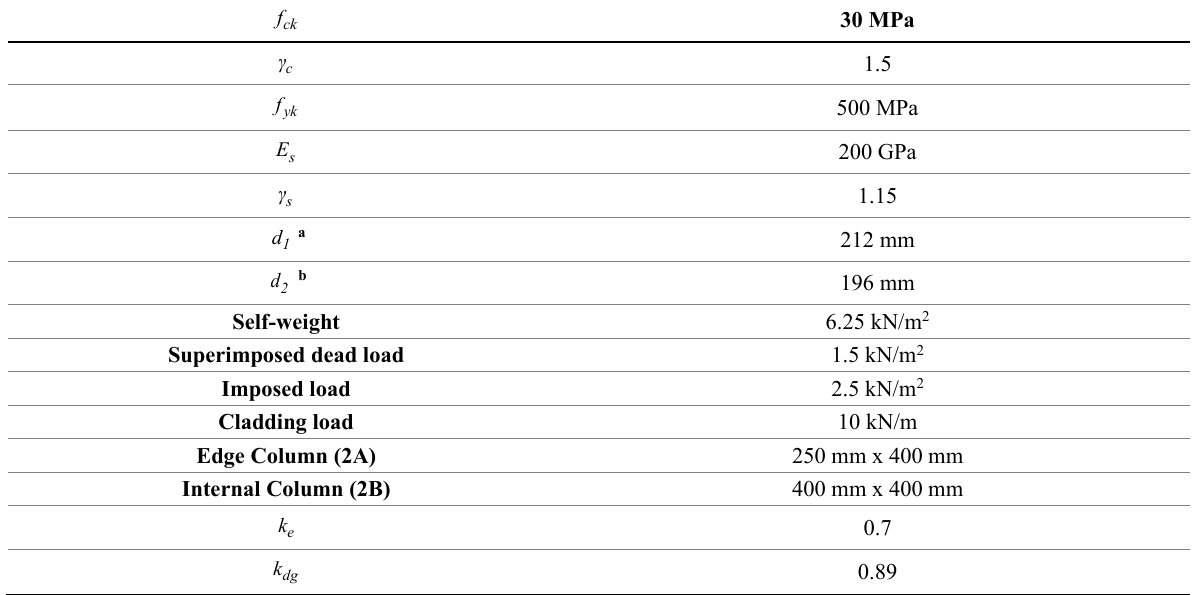
Table 2. Details on the parametric study varying the reinforcement arrangement.